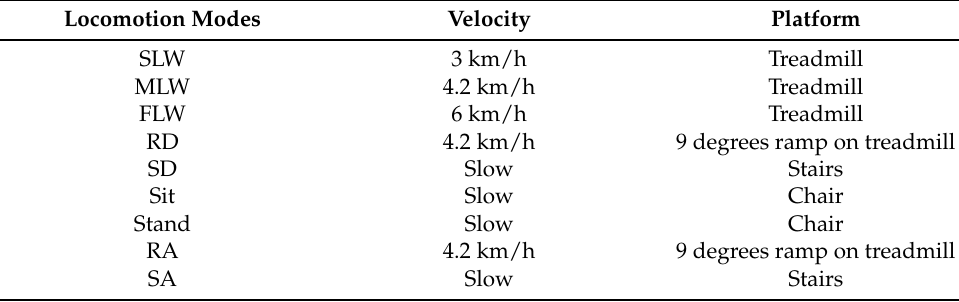
Table 1. Velocity and experimental platform of locomotion